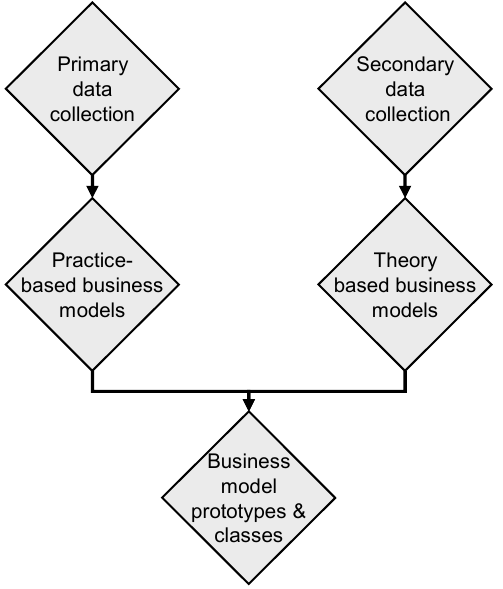
Figure 2. The procedure of business model search, typing and classification.